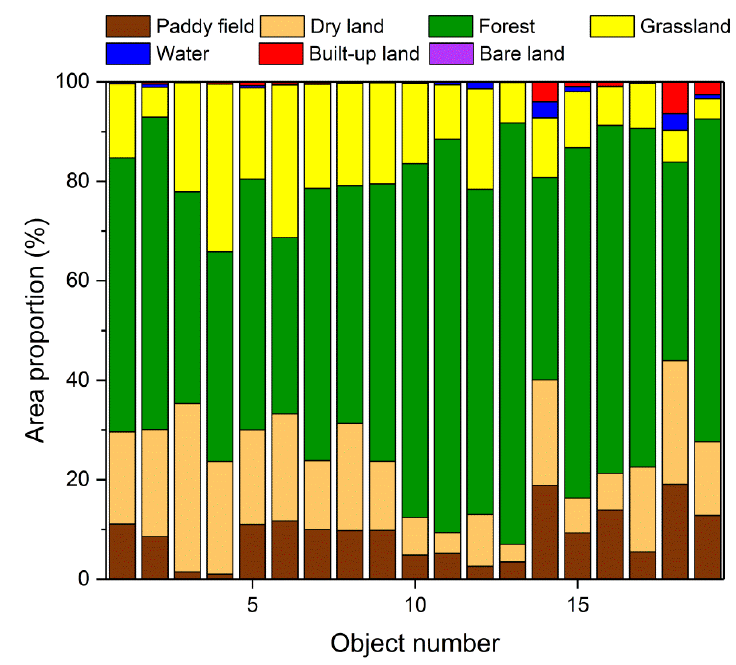
Figure 7. Land use structure within stratifications at the optimal segmentation size.